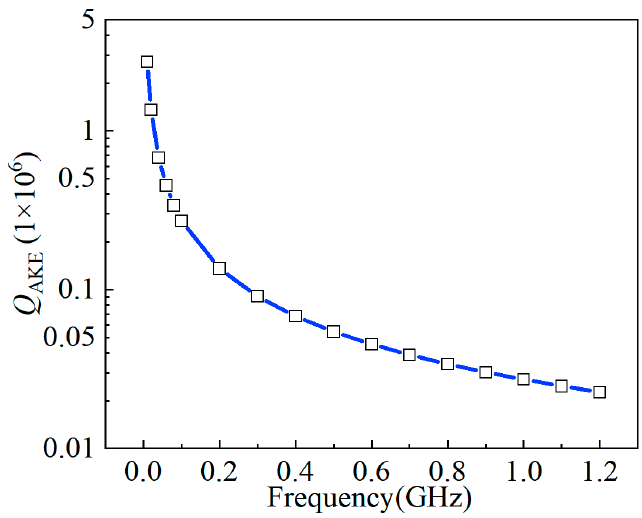
Figure 6. The frequency dependence of Q AKE .